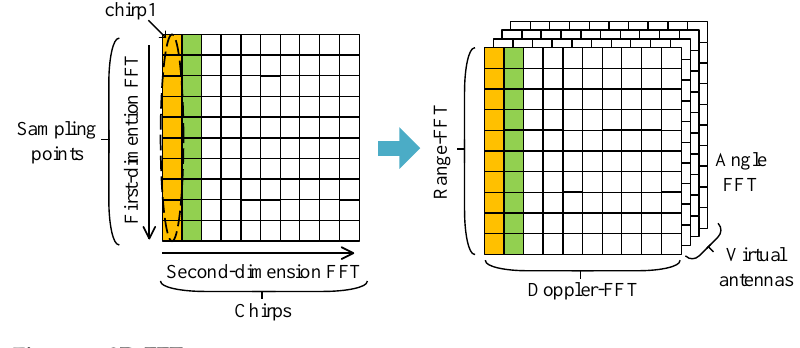
Figure 2. 3D-FFT